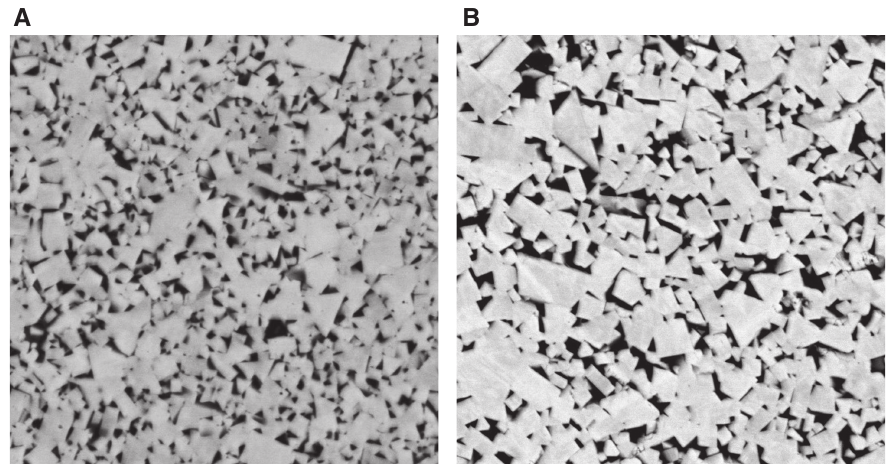
Figure 1: Micrographs of cemented carbide containing (A) 6% of cobalt and (B) 9% of cobalt. A B